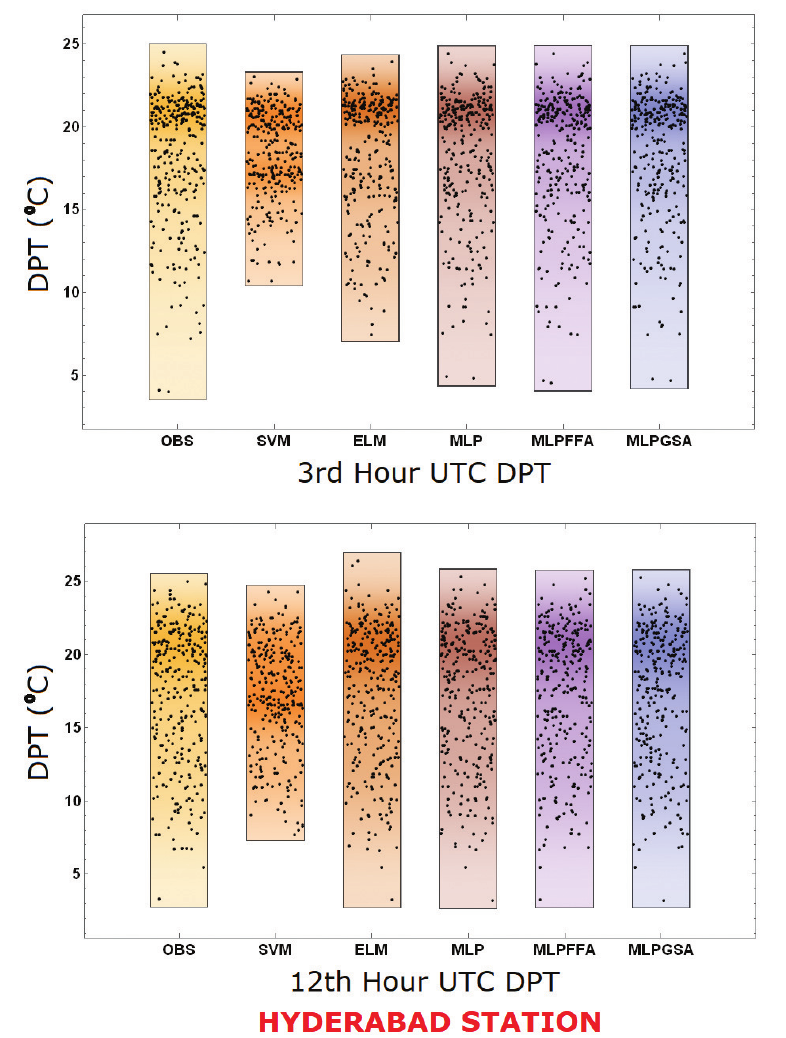
Figure 7. Point density plots of observed vs. estimated DPTs with respect to Hyderabad